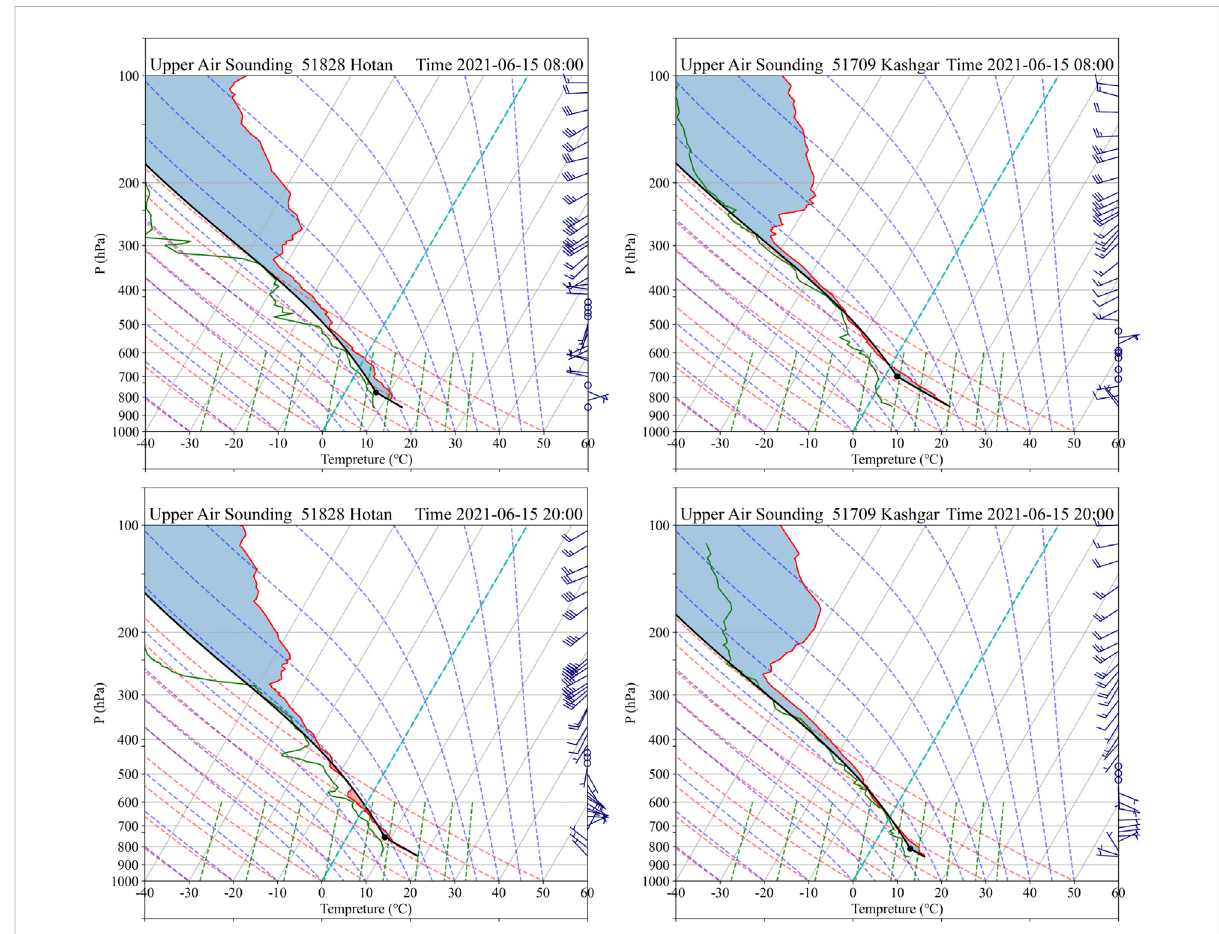
FIGURE 6 The T-lnP diagrams at 08:00 and 22:00 for the sounding stations at (A,C) Hotan (ID 51828) and (B,D) Kashgar (ID 51709) on 15 June 2021. The dark blacksolidlinesindicate statepro fi les. Thered solidlinesaretemperaturestrati fi cationpro fi les. Thegreensolidlinesare dewpointstrati fi cation pro fi les. The blue dashed lines arewet adiabatic pro fi les. The orange dashed linesare dry adiabatic pro fi les. The green dashed lines are iso-saturated speci fi c humidity pro fi les. The gray sloping solid lines are isothermal pro fi